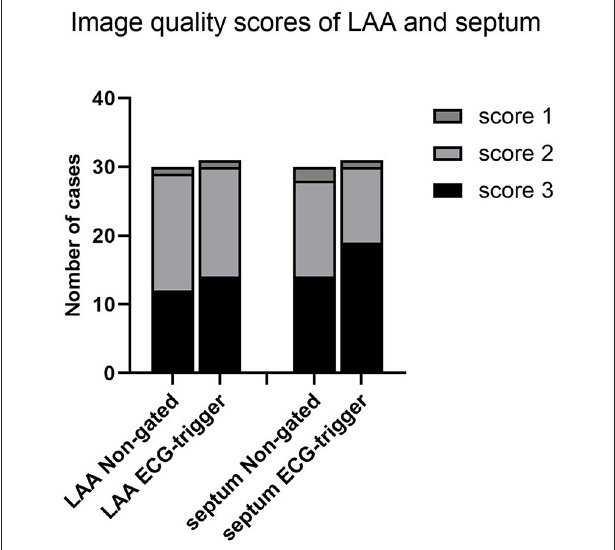
FIGURE 2 | Image quality scores of the left atrial appendage (LAA) and